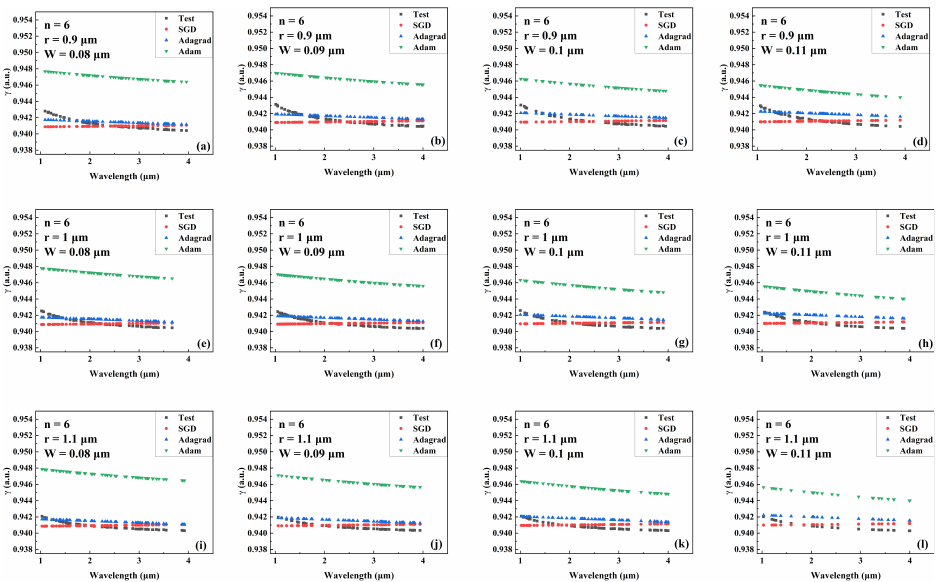
Figure 10. Comparison the predicted and actual values of γ in the test data set of the network model trained by different optimizers for different combinations of core radius and cantilever width (number of cantilevers: 6). ( a ) r = 0.9 µ m, W = 0.08 µ m. ( b ) r= 0.9 µ m, W = 0.09 µ m. ( c ) r = 0.9 µ m, W = 0.1 µ m.